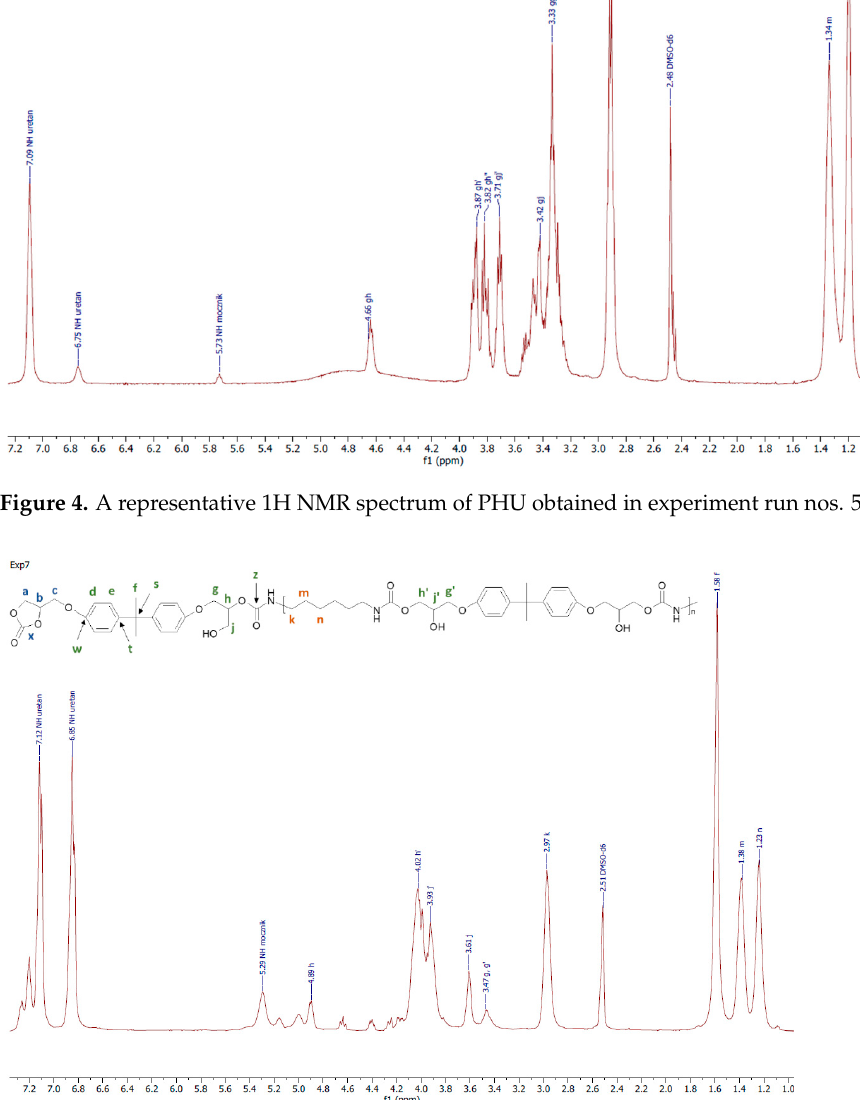
Table 4. Lap shear strengths of PHUs bondlines in pinewood. PHU no.